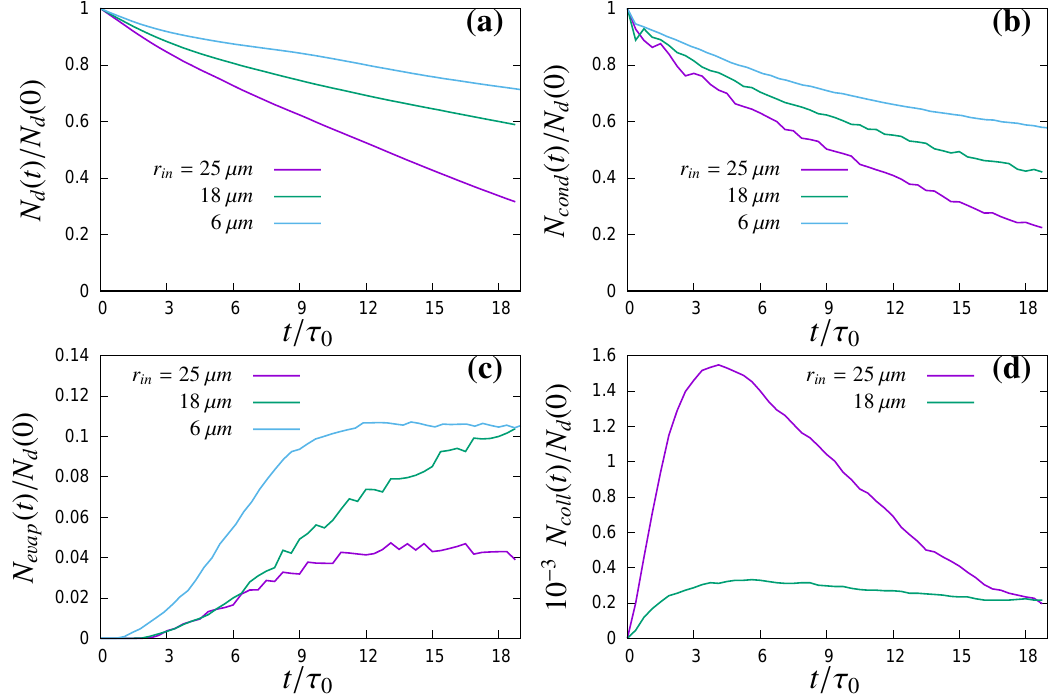
Figure 8. Transient evolution in normalized number density of droplets: ( a ) number density of total number of cloud droplets N d ( t ) ; ( b ) number density of droplets went through condensational growth N cond ( t ) ; ( c ) number density of droplets undergone evaporative size reduction N evap ( t ) ; and ( d ) number density of droplets with one collision N coll ( t ) as observed for 25 µ m, 18 µ m and 6 µ m initial droplet size populations. No collisional growth is observed for 6 µ m initial droplet